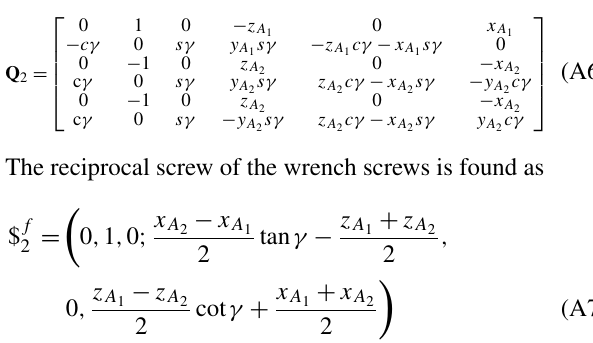
Figure A1. General 3-PPS PKM described by screws. Figure (A1) shows all twist screws of the